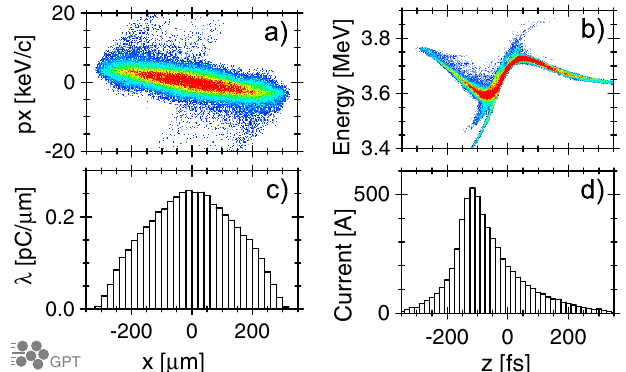
FIG. 3. (Color) (a) Transverse phase space, (b) longitudinal phase space, (c) transverse line-charge density, and (d) current profile at the combined longitudinal and transverse focal plane at z (cid:1) 1 : 5 m , obtained with 100 k multiparticle GPT simulations. The online colors indicate particle density and range from blue (low density), via green and yellow to red (highest